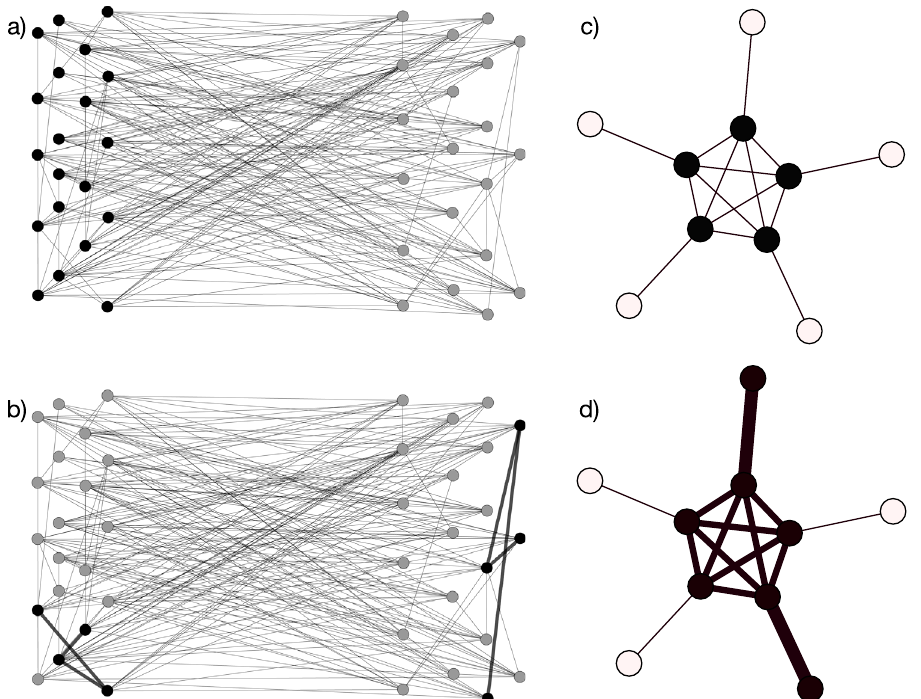
Fig. 7 Impact of weights on the detection of bimodular structures. The presence of weights affects the detection of bimodular mesoscale structures as well. In fact, rising the weight of any two links connecting the core with the periphery of a toy network allows the two nodes originally part of the periphery ( a ) to be detected as belonging to the core ( b ); analogously, if a bipartite binary topology ( c ) is modi fi ed by adding weights between some of the nodes belonging to the same layer ( d ), a core-periphery structure will be detected as signi fi